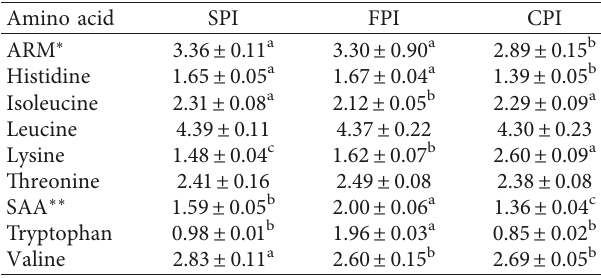
Table 1: Essential amino acids (g/100g protein) of defatted oilseed protein isolates.